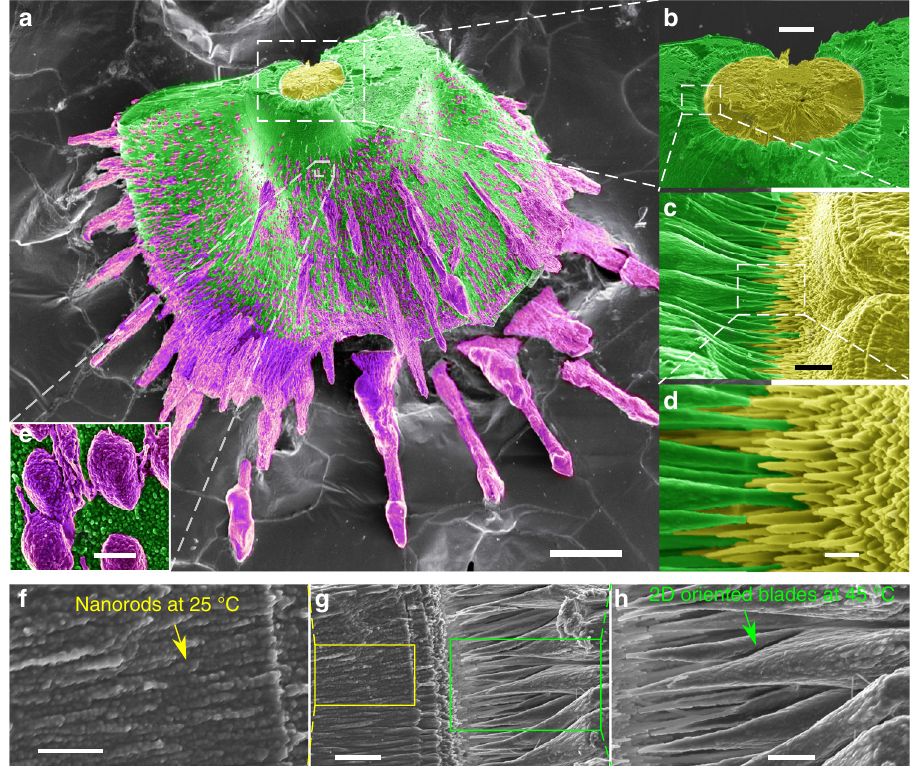
Fig. 4 Heterotextured complexity of MHC. The growth periods at different temperatures have been labeled with false colors ( a ): 24 h growth at 25 °C (yellow), 6 days growth at 45 °C (green), 24 h growth at 70 °C (magenta), successively. The close-up views ( b – d and f – h ) show the transition from the spherulitic core (yellow) grown at 25 °C to the biomorphic laminar sheet (green) grown at 45 °C. The close-up view with higher magni fi cation ( d ) shows the gradual transition of the textures from micron-size long rods of one hundred nanometer in thickness (25 °C, yellow) to 2D oriented blades (45 °C, green); close-up view ( e ) shows the mesocrystal with crystallographic symmetry made by nanodrops aggregation on the surface of laminar sheet at 70 °C (magenta). Close-up views ( f – h ) shows further details of the transition from nanorods to blades and also show that both, the nanorods and the blades are made by accretion of nanodrops. Scale bars: 100 μ m ( a ), 20 μ m ( b ), 2 μ m ( c , g ), 500 nm ( d ), 1 μ m ( e , f , h )